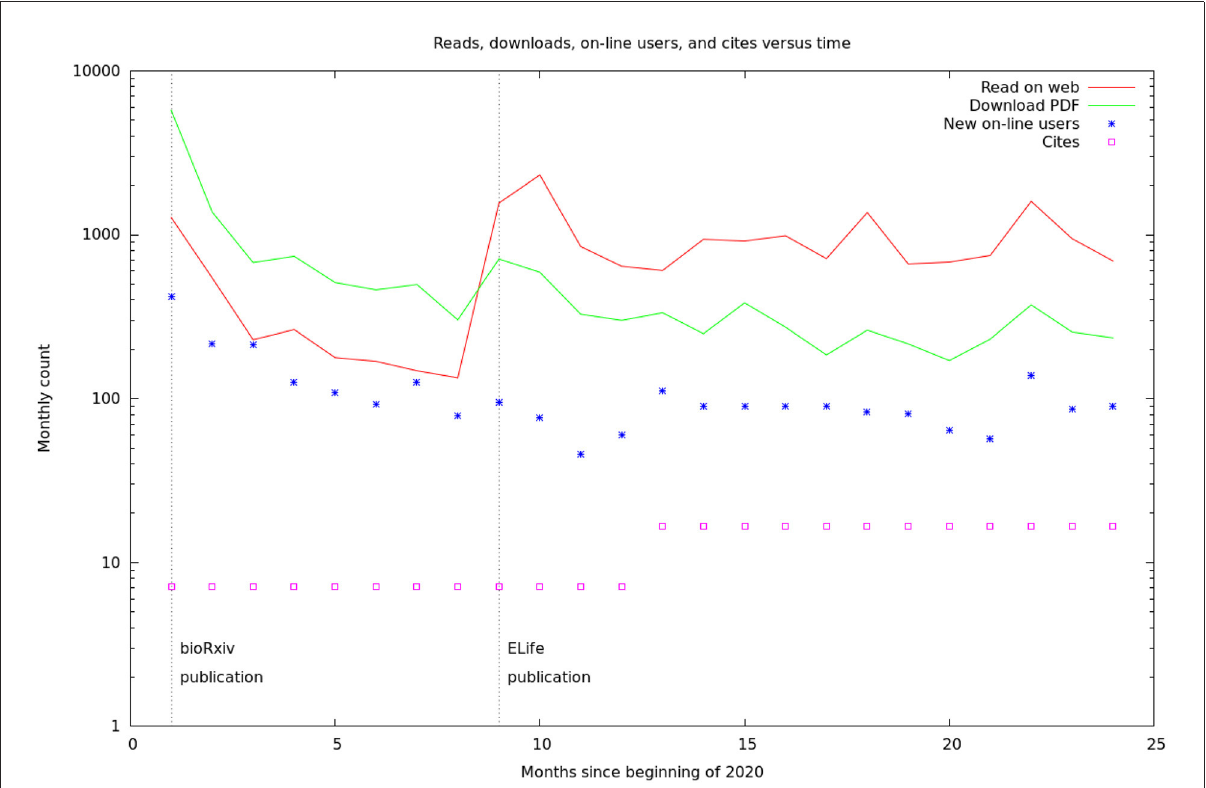
FIGURE5 Relative rates of readership, database access, and cites. The readership and download rates are the sum of the figures from the bioR χ iv and eLife sites. The database access rates are from our logs. The citation rates are from Google scholar, but are only shown yearly and have been converted to monthly rates for this graph. The vertical lines are the initial BioRxiv publication (Xu et al., 2020) and the formal, peer-reviewed eLife article (Scheffer et al.,